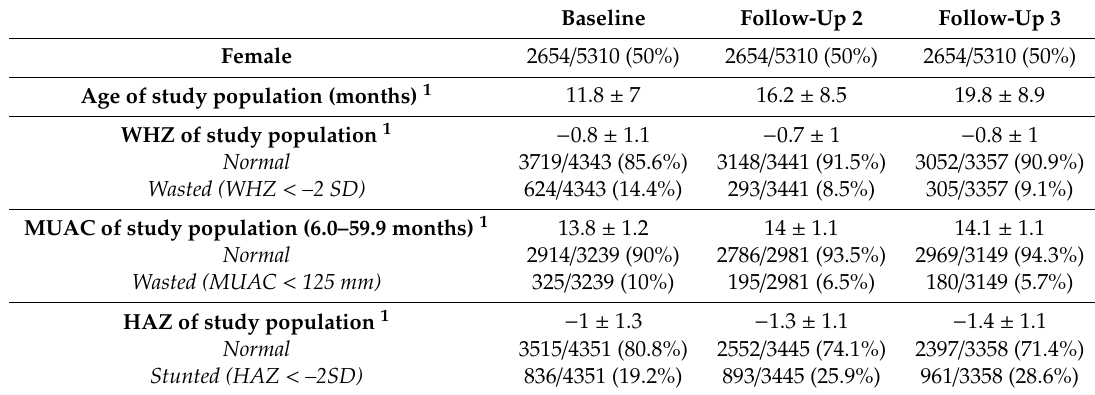
Table 1. Description of study population: age, gender, anthropometric measurements by study visit. Baseline Follow-Up 2 Follow-Up